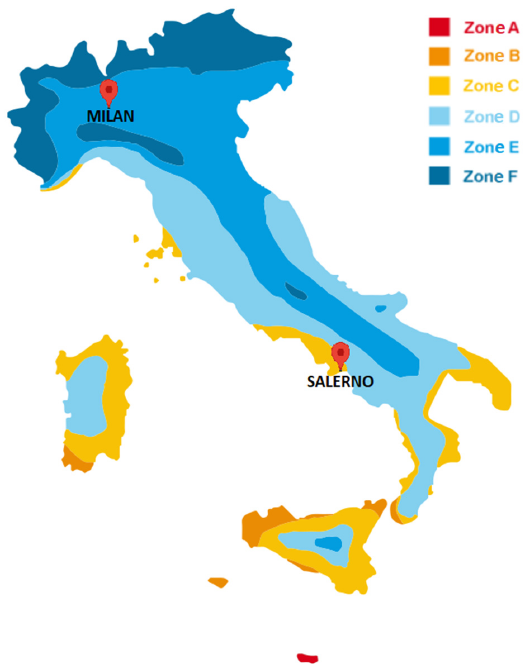
Figure 1. Map of Italy divided into climate zones and location of the cities of Milan and Salerno. Milan, in Lombardy, located in the northwestern region of the Italian peninsula, belong- ing to the cold-temperate zone E and characterized by an external design temperature [16] of − 5 ◦ C, was considered. The other analyzed city was Salerno, a city in central-southern Italy facing the Tyrrhenian Sea, belonging to mid-temperate zone C and having an external design temperature of 2 ◦